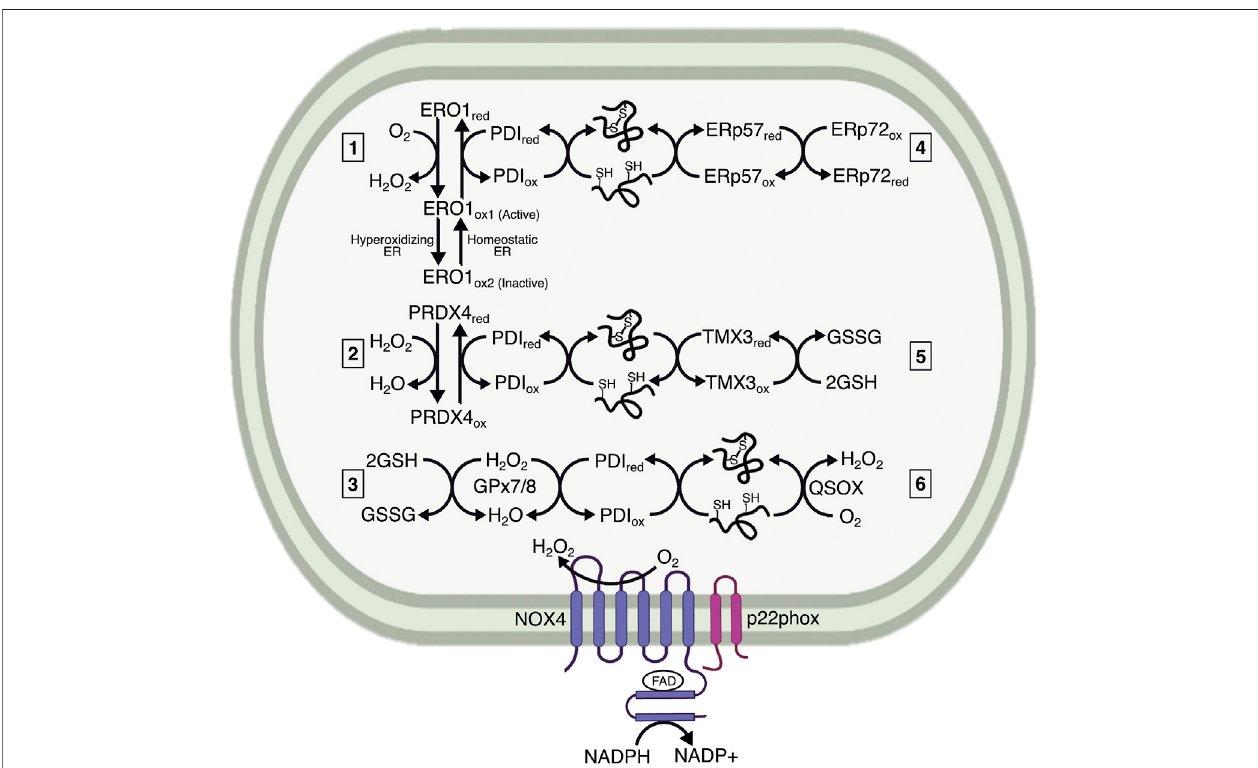
FIGURE 1 | Mechanisms maintaining the oxidative capacity of the ER lumen. The ER lumen must be suf fi ciently oxidizing to maintain protein folding. It is characterized by a high preponderance of GSSG, which is generated by ER-localized GPx7/8 as a method of neutralizing H 2 O 2 . The extent to which GSSG in fl uences proteinfoldingremainsless understood. ThemainERresident proteinscontrollingoxidativefoldingarethePDIfamily members.PDIsaremaintainedinanoxidizedstate byelectron transferto1) ERO1,generatingH 2 O 2 inthe process; 2)PRDX4, whichneutralizes H 2 O 2 ;and 3)GPx7/8, whichalso neutralizes H 2 O 2 .BothPRDX4 and GPx7/8 likely use H 2 O 2 generated by ERO1 or NADPH oxidase 4 (NOX4) to reoxidize PDI. ERO1 also undergoes redox-mediated regulation by existing in two oxidized states, indicatedhere asERO1 ox1 and ERO1 ox2 , wherein the ox1 state has oxidized catalytic cysteines and reduced regulatorycysteines, and is therefore active, versus ox2, which has oxidized regulatory cysteines and is therefore inactive. The ox1 form predominates under normal ER lumenal conditions, whereas the ox2 form is generated with the ER lumen becomes hyperoxidizing. Additional interactions are proposed between PDI family members, represented here by ERp57 (PDIA3) and ERp72 (PDIA4). 4) These interactions could be involved with both oxidation for initial disul fi de formation and reduction for disul fi de isomerization. Some PDIs, such as TMX3, are proposed to interact directly with GSH, which reduces PDI for disul fi de reduction and isomerization. 5) Finally, a potential mechanism for protein oxidation